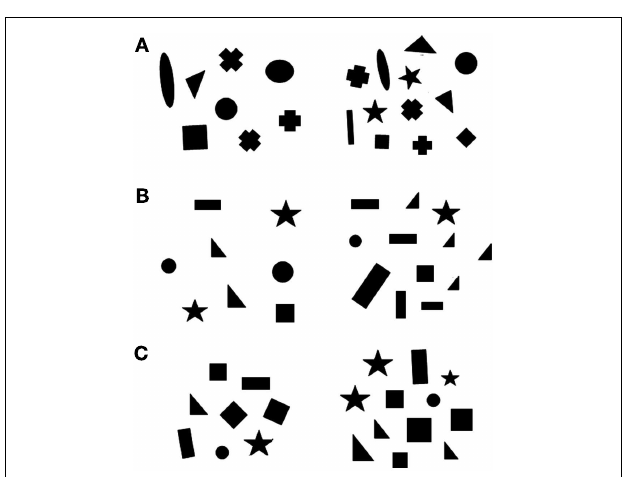
FIGURE 2 | Schematic representation of the stimuli used. Each panel contained black geometric figures differing in numerosity inserted in a white background. In the figure we depicted a 8 vs. 12 contrast with cumulative surface area controlled to 100% (A) , to 85% (B) and to 70% (C) . In (A) and (B) stimuli are controlled for overall space, whereas in (C) they are controlled for density.